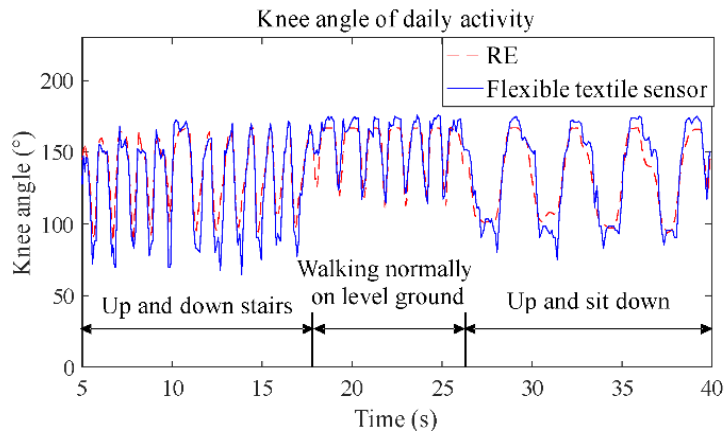
Figure 6. The comparison of angle measurement between the RE system and the flexible textile sensor.